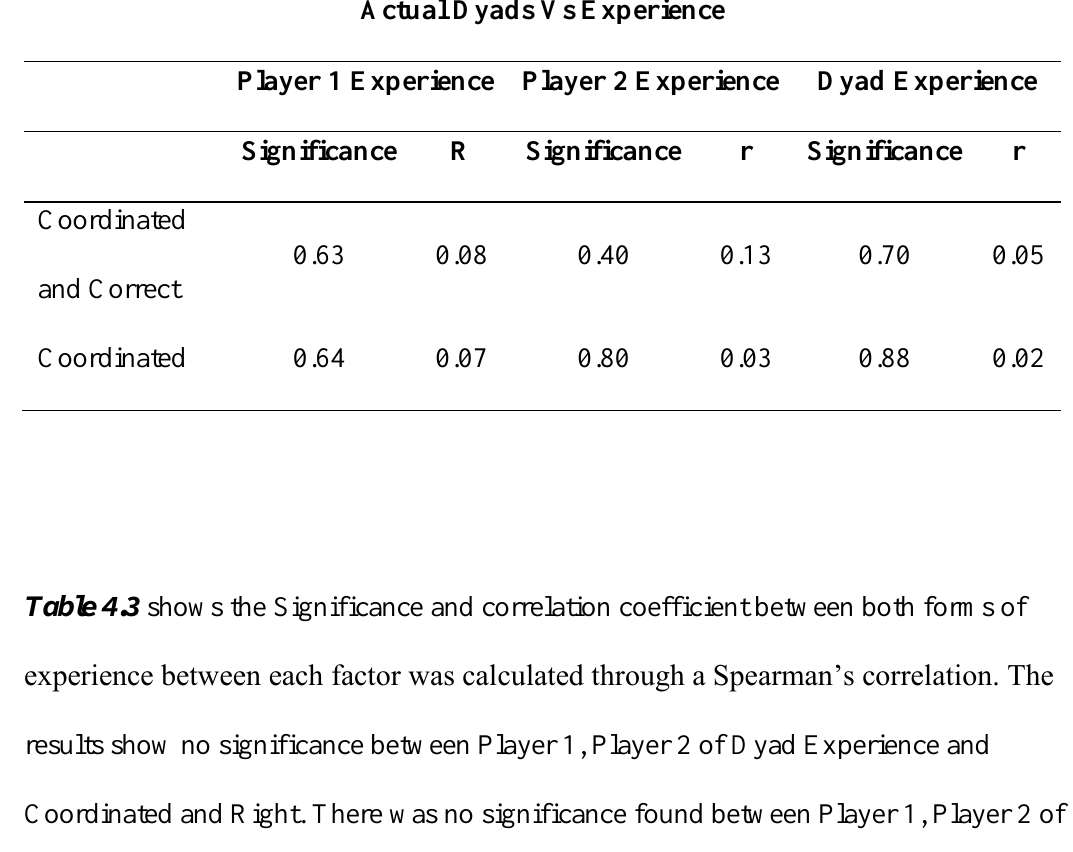
Table 4.11 – Actual Dyad comparison between individual and combined